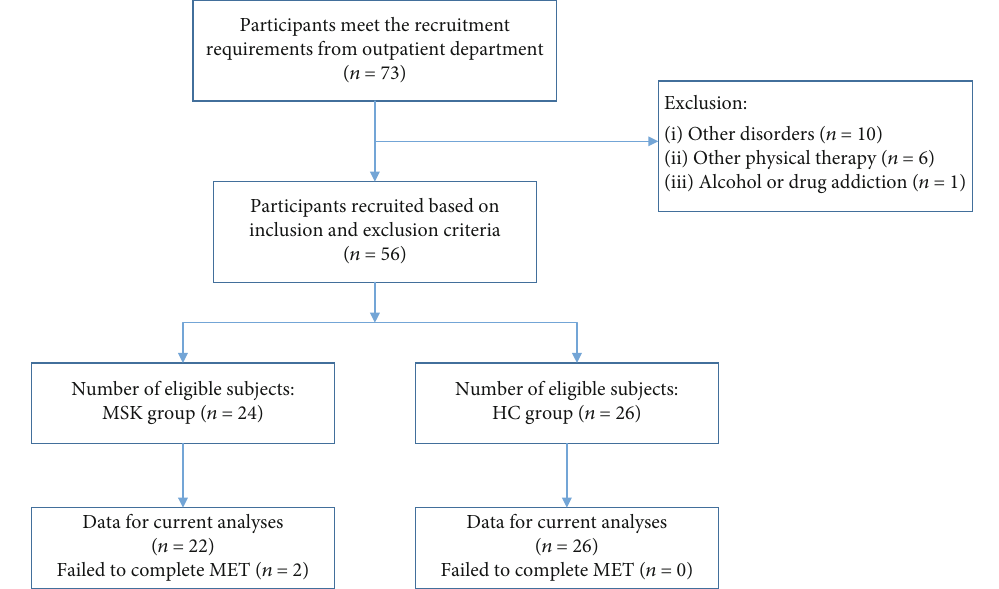
Figure 1: The fl ow chart of the